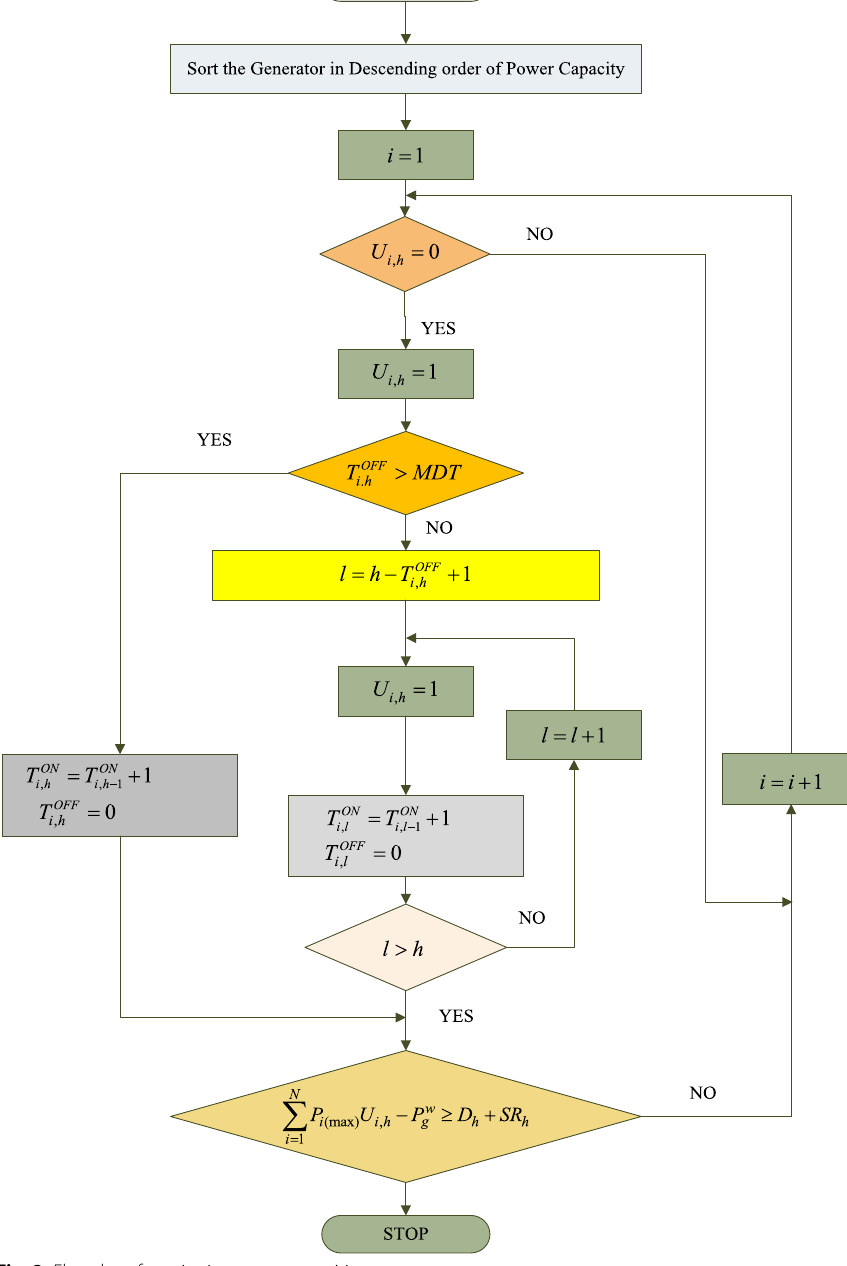
Fig. 2 Flowchart for spinning reserve